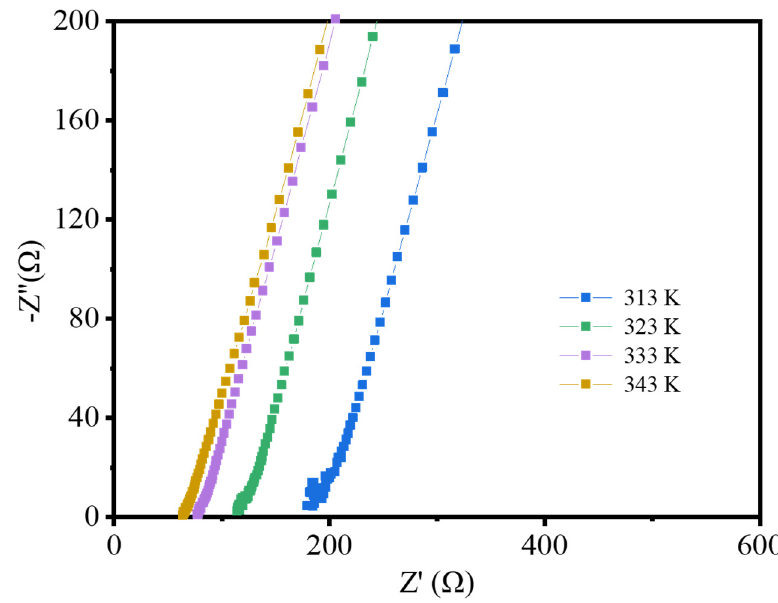
Figure 8. Electrochemical impedance spectra of 1T-MoS 2 -600 at an increasing temperature of 313, 323, 333, and 343 K, respectively.